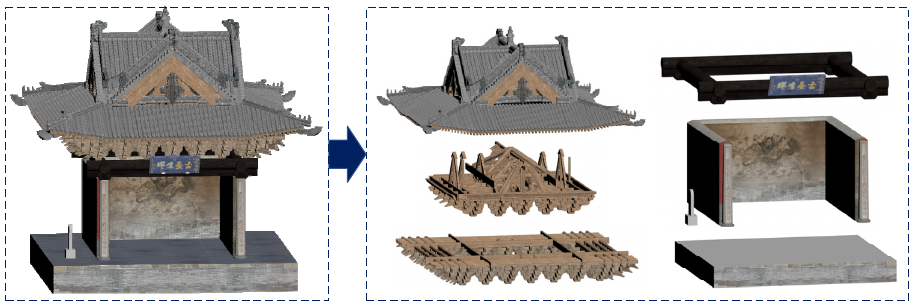
Figure 8. Three-dimensional model of Houtu Temple Stage.